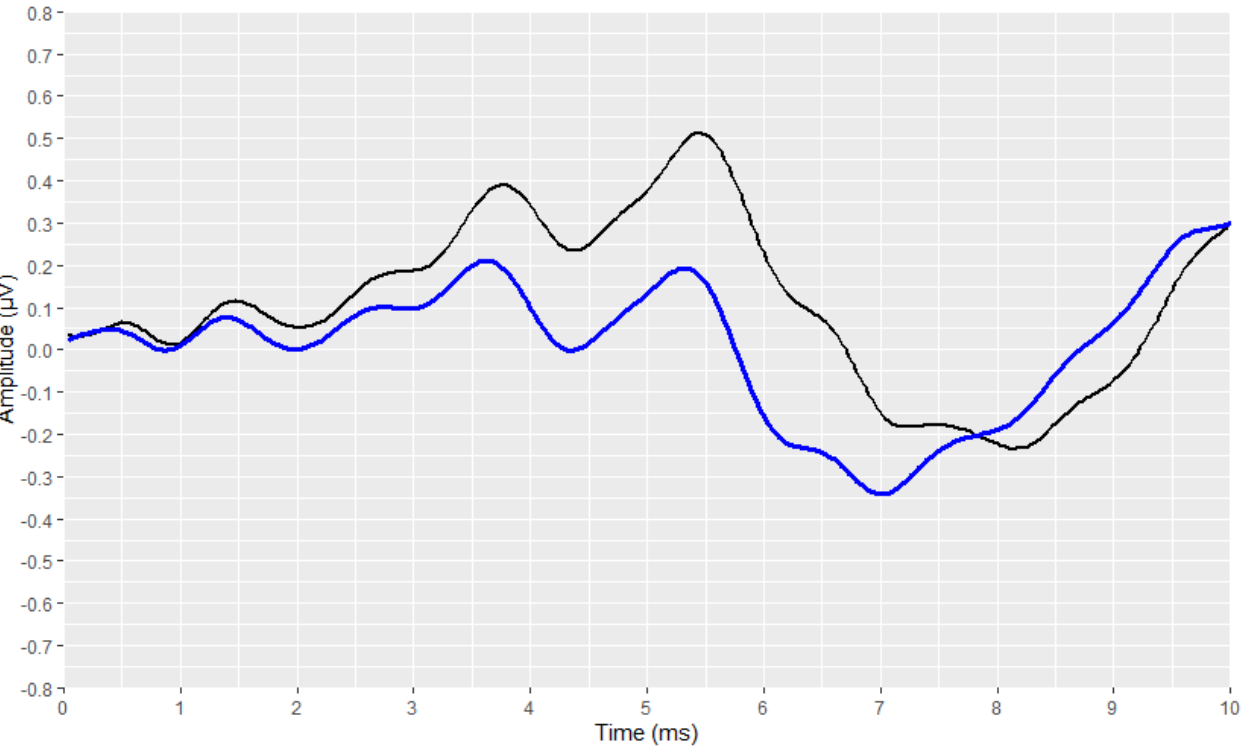
Figure 6. Visualization of an ABR waveform after applying the visual display filters (raw signal is depicted in black and filtered signal is depicted in blue).